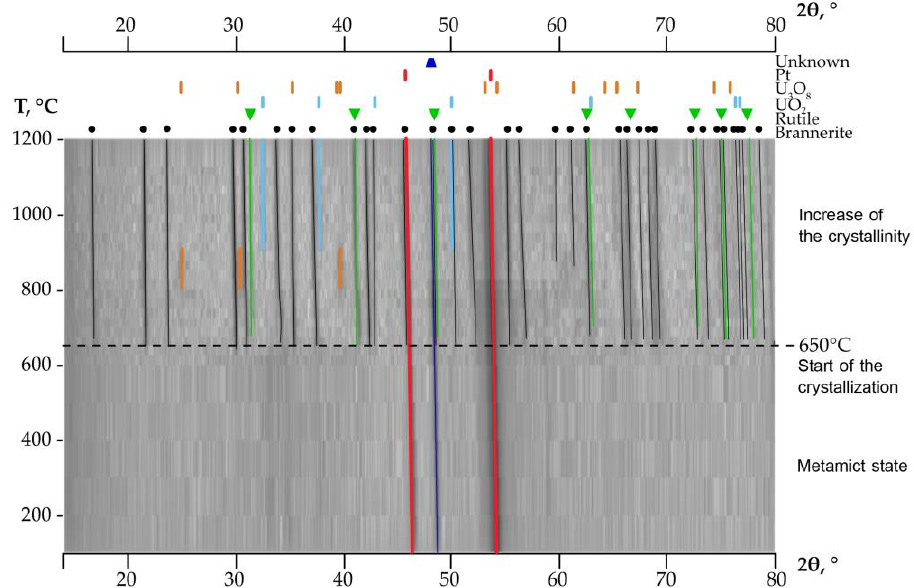
Figure 4. Evolution of X-ray powder diffraction patterns of the metamict brannerite in the range 100–1200 ◦ C. There is no evidence of recrystallization until 625 ◦ 100 – 1200 °C. There is no evidence of recrystallization until 625 °C.